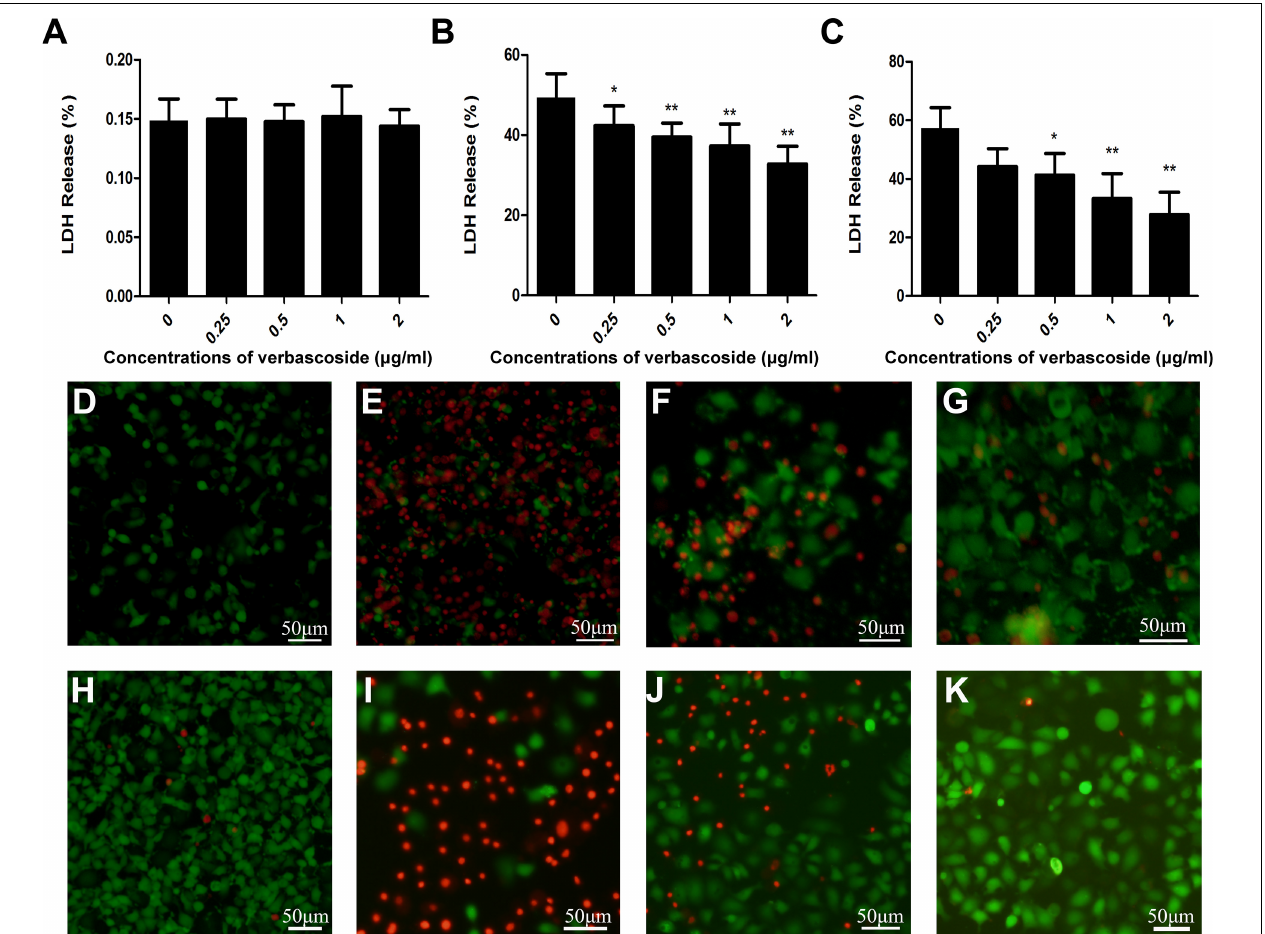
FIGURE 3 | Verbascoside protected Caco-2 cells from injury induced by PFO or CPA. (A) Verbascoside was incubated with Caco-2 cells for 5 h, and cytotoxicity was detected by a cytotoxicity detection kit. Verbascoside reduced the cell damage caused by (B) PFO and (C) CPA. Caco-2 cells were cocultured with verbascoside preincubated with PFO (B) or CPA (C) for 5 h, and cytotoxicity was detected by a cytotoxicity detection kit. The data are shown as the mean ± SD values of three independent experiments. P values were calculated using one-way analysis of variance (ANOVA; * P < 0.05 and ** P < 0.01). Caco-2 cells were cocultured with verbascoside preincubated with (D–G) PFO or (H–K) CPA for 5 h and observed under fluorescence microscope using the live/dead (green/red) reagent. Green and red represent live and dead cells, respectively. Scale bar, 50 µ m.